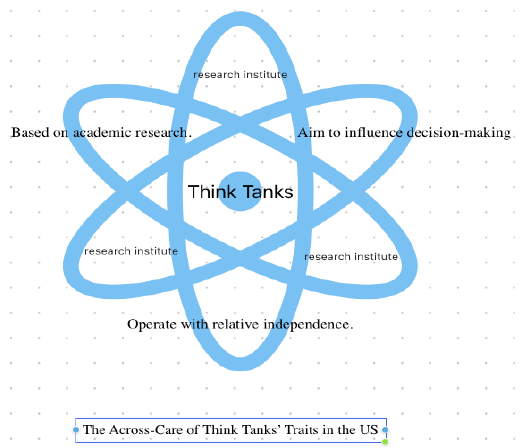
Figure 1. The across-care of think tanks in the